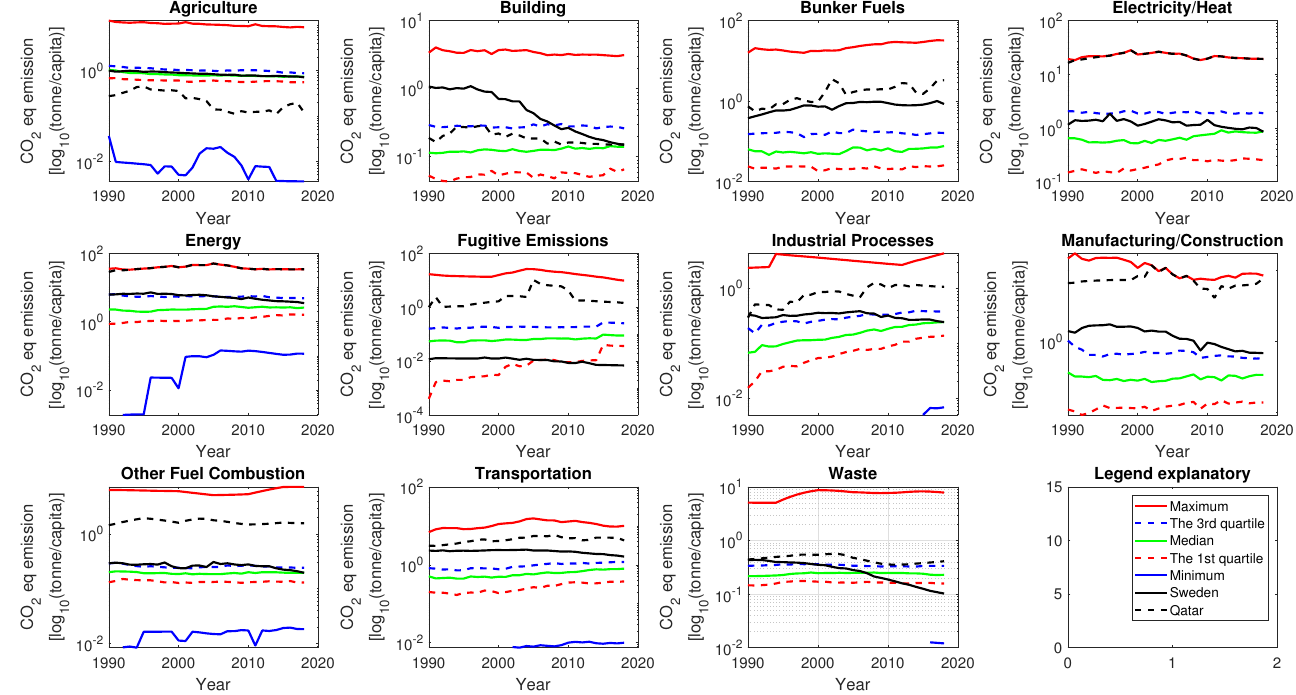
Figure 6. Percentile plot of total GHG emission per countries. Based on country emissions data, percentile values can be calculated each year to obtain the maximum, the third quartile, median, first quartile, and minimum functions. The figure can be used to determine the role of a country in damaging the environment. In this example, Qatar has the highest damaging potential during the past years. However, Sweden has reduced the GHG emission significantly from the third quartile to the